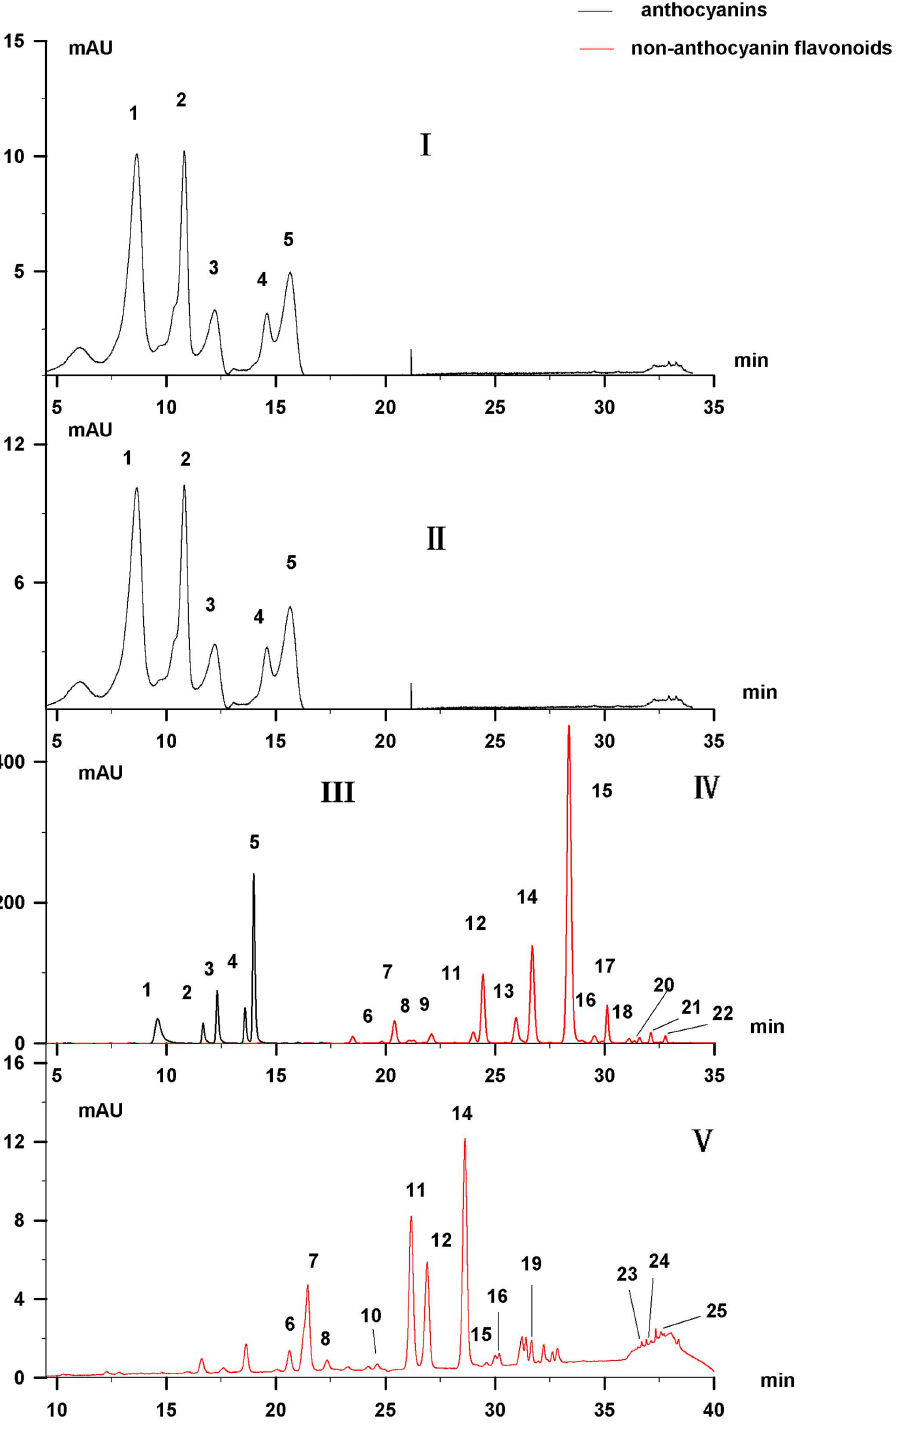
Figure 1. HPLC chromatograms (HPLC-DAD/MS) at 520 nm of anthocyanins (I, II, III) and at 350 nm of non-anthocyanin flavonoids (IV) extracted from flower petals of cultivar ‘Zhuguang’ under an elution system with 0.5% (I, IV), 2% (II) and 5% (III) formic acid. Five anthocyanins (peaks 1–5) were satisfactorily separated with 5% formic acid (III) and twenty non-anthocyanin flavonoids (peaks 6–25) with 0.5% formic acid (IV) in flower petals and stalks. Peak numbers in this figure correspond to compound numbers in Table 2.